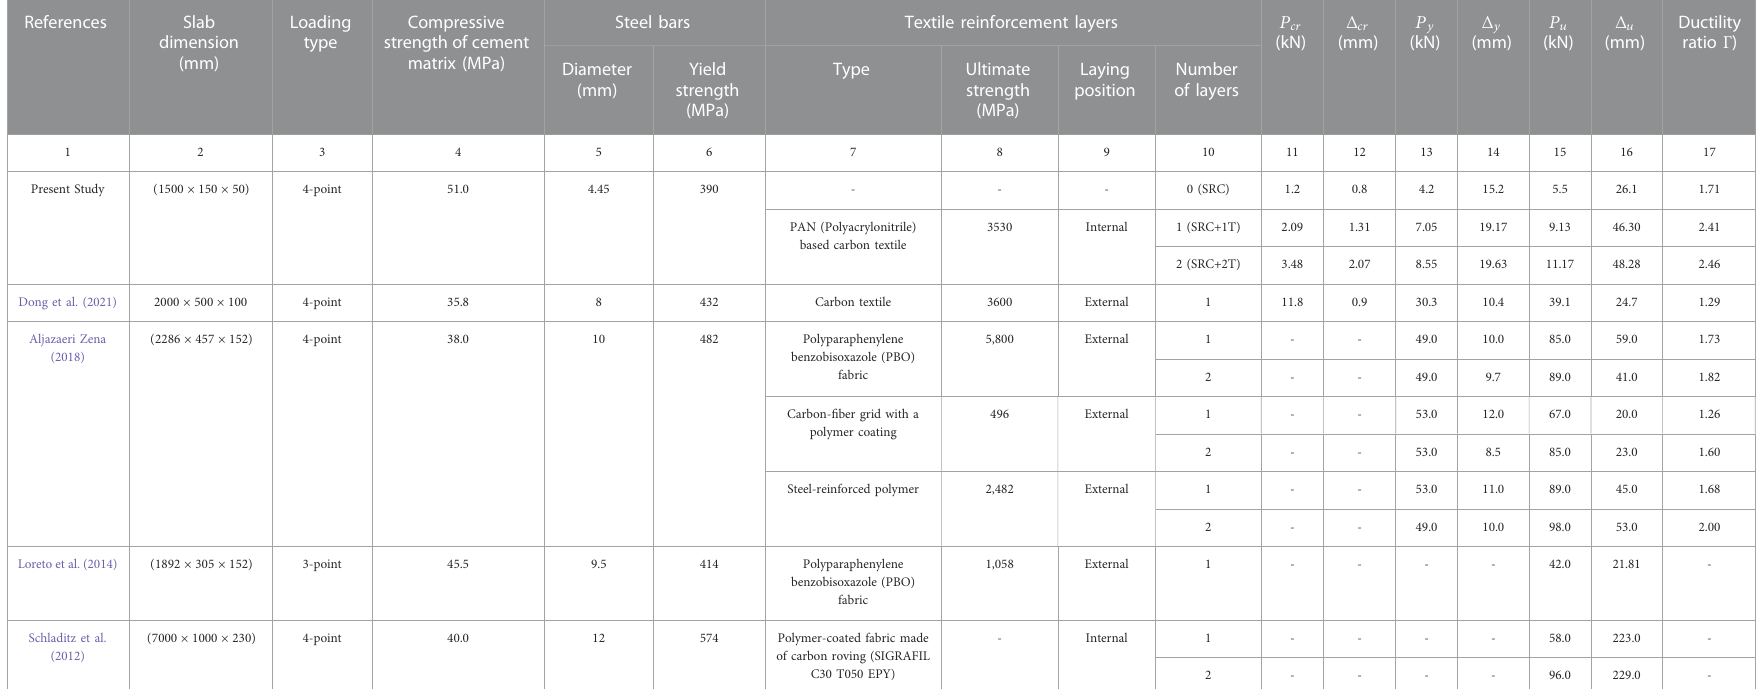
TABLE A1 Results of the present experimental test and its comparison with existing literature